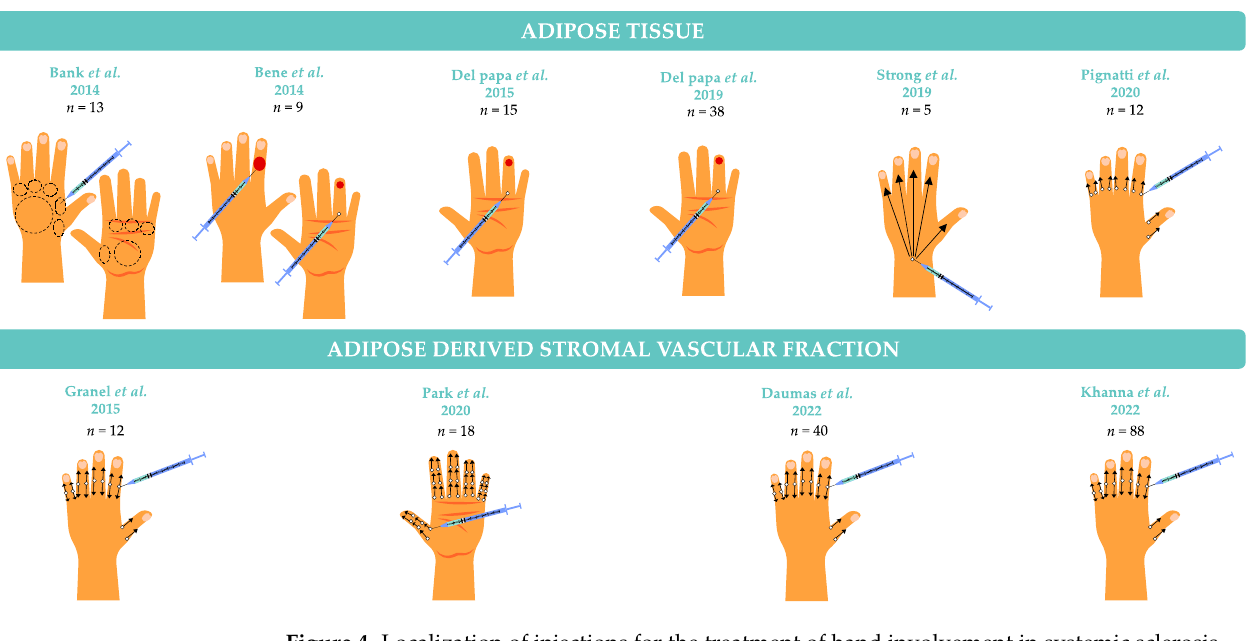
Figure 4. Localization of injections for the treatment of hand involvement in systemic